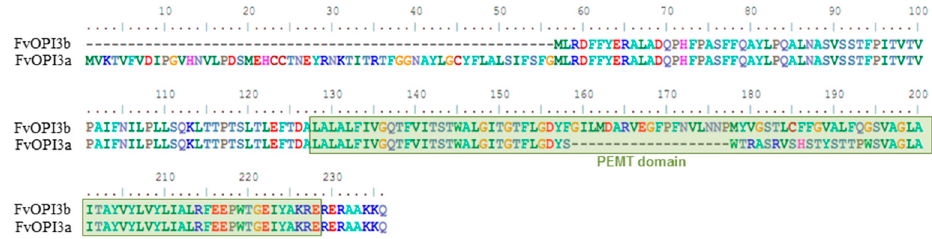
Figure 6. A comparison of the amino acid sequence of the two isoforms of F. velutipes Opi3 proteins. The PEMT domain is circled in green.